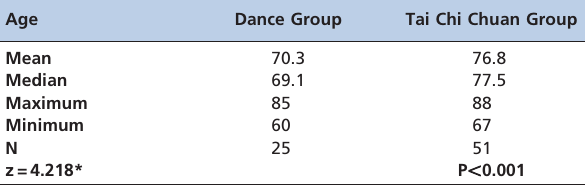
Table 2 - Characterization of the age of the sample: mean, median, maximum and minimum values.